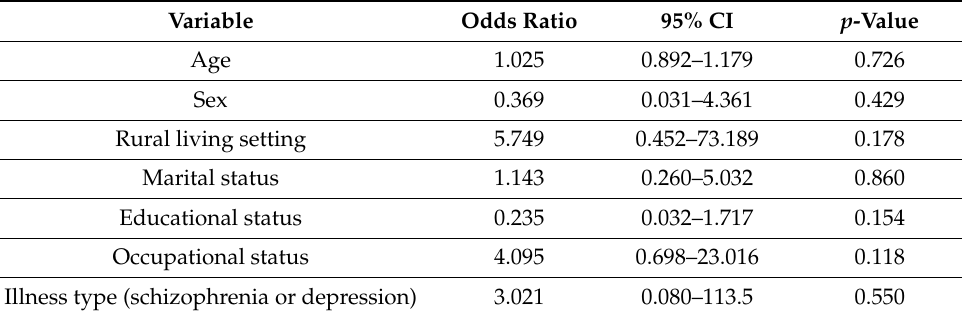
Table 6. Internet use (yes or no)—multivariate regression